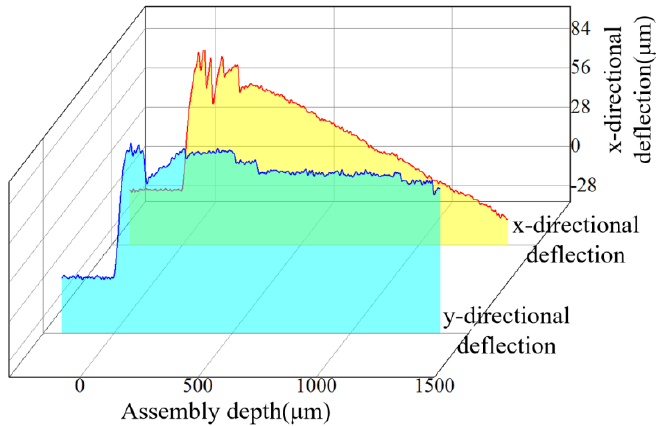
Figure 13. Diagram of hohlraum’s offset.